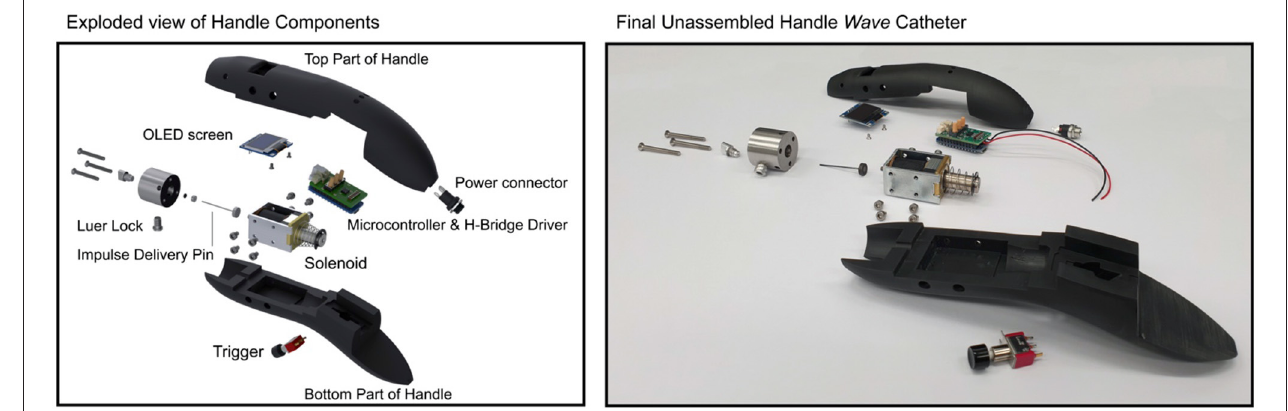
FIGURE 12 | Exploded view of the final handle design.